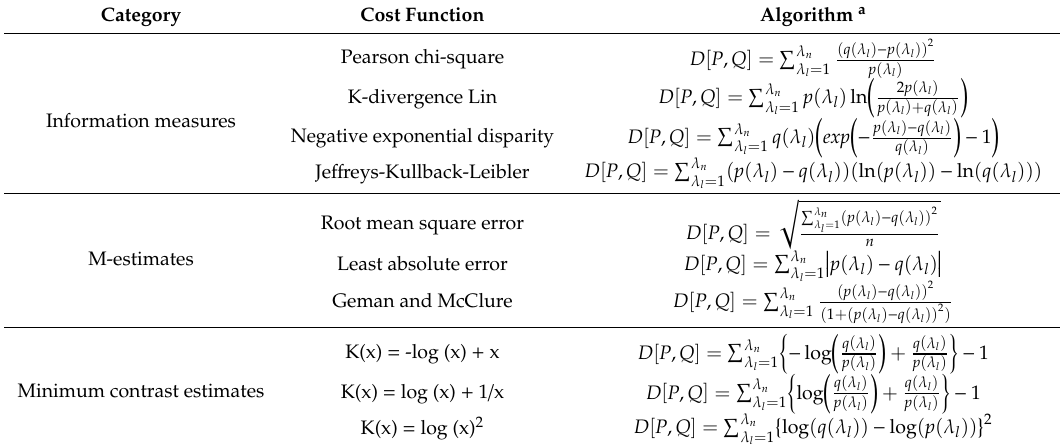
Table 5. Cost functions used in the present